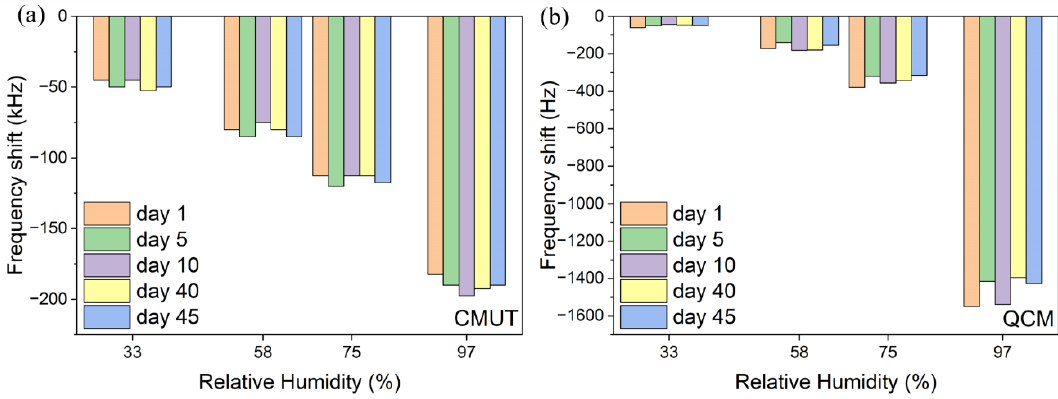
Figure 11. Long-term stability performance of the sensors: ( a ) CMUT; ( b ) QCM. Table 1. Comparison between the humidity sensors in this work and reported gravimetric humidity sensors.